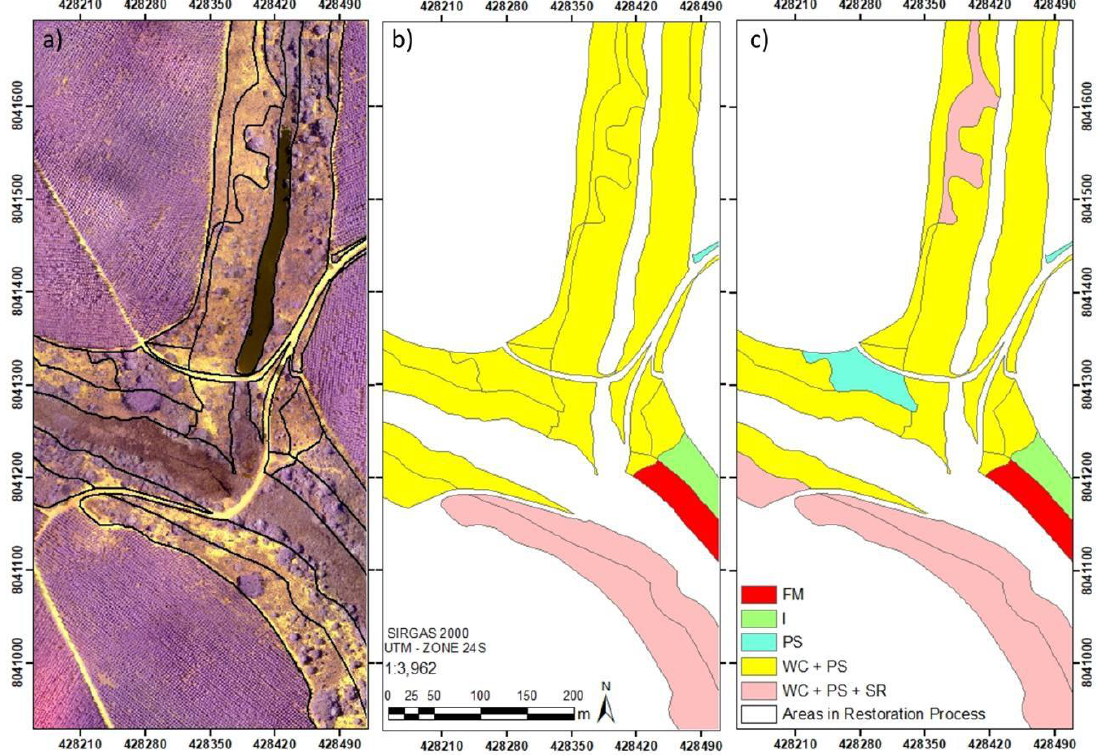
Figure 4. ( a ) UAV camera images (red, green, near infrared, NDVI, SAVI), which represent part of the study area; ( b ) management recommendations generated by UAV image classified with maximum likelihood algorithm; ( c ) management recommendations generated by UAV image classified with random forest algorithm. FM: Field monitoring, I: Isolation, WC + PS: Weed control + plant seedling, WC + PS + SR: Weed control + plant seedling + bare soil recovery.